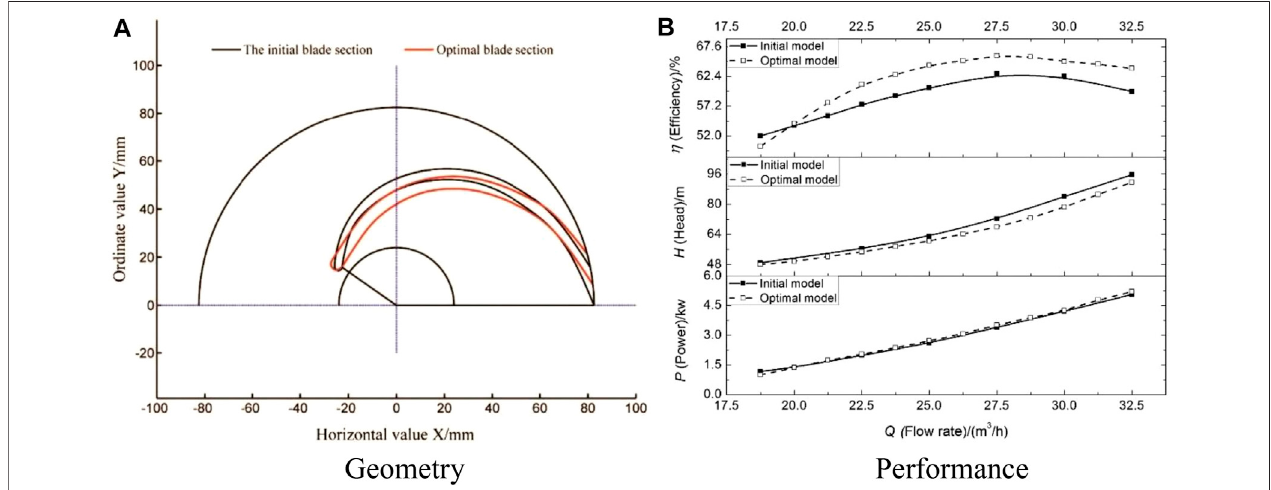
FIGURE 5 | Geometry and performance of initial and optimal PAT models (Miao et al., 2015). (A) Geometry, (B) Performance.